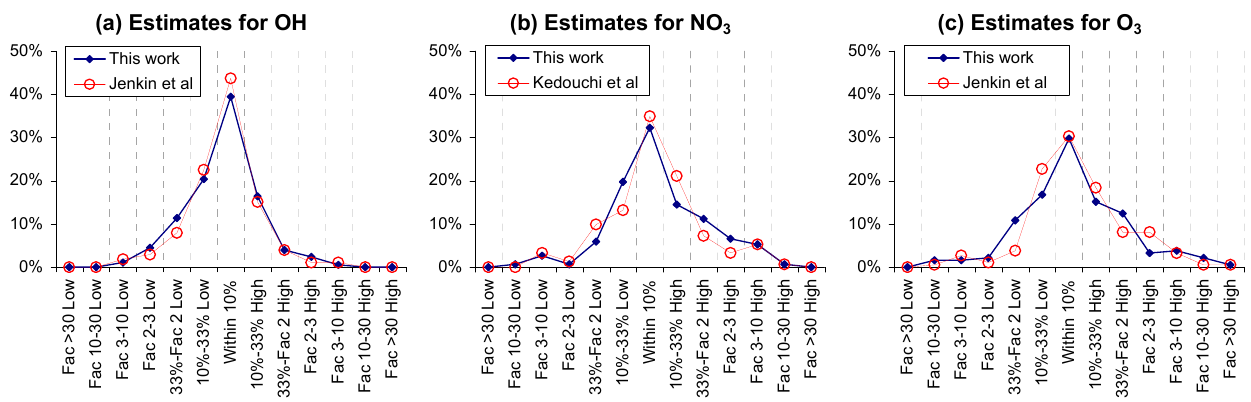
Figure 5. Comparison of distribution plots of factor errors for estimates from Jenkin et al. [29,30,32] and Kedouchi et al. [31] with those from this work.